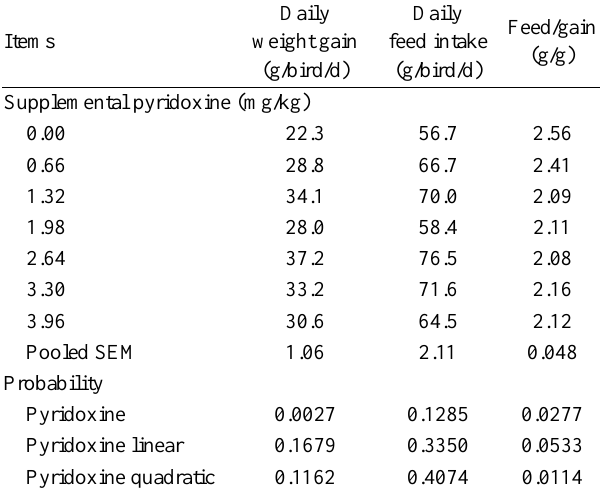
Table 2. Effects of pyridoxine on growth performance of White Pekin ducks from hatch to 28 days of age 1